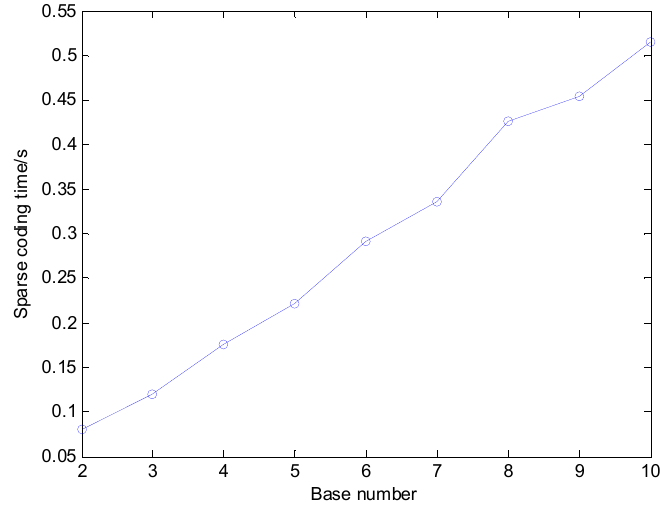
Figure 11. Average sparse coding time using different K .